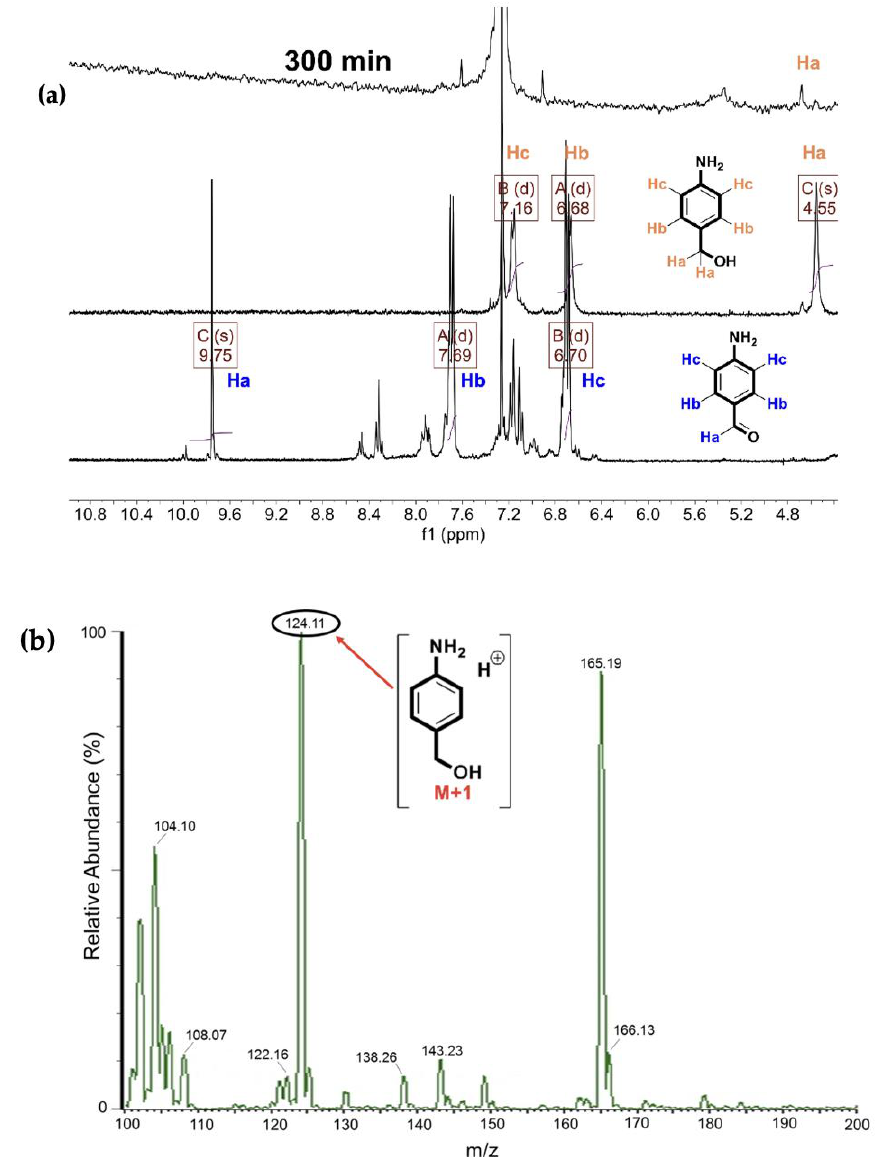
Figure 10. ( a ) from bottom to top the spectra of 4-aminobenzaldehyde, 4-aminobenzyl alcohol and crude of reaction after 300 min of irradiation; ( b ) on right the ESI-MS spectrum of crude of reaction after 300 min.